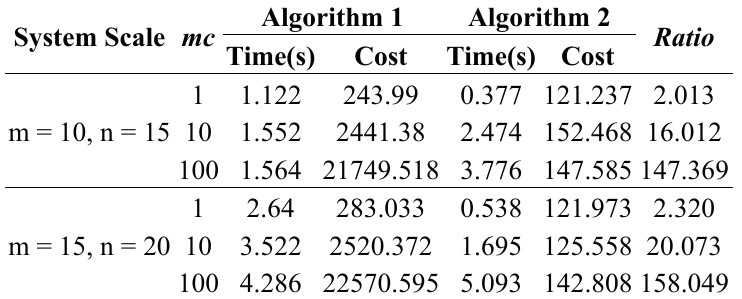
Table 6. Simulation result for the imperfect test cases (N = 100, L =